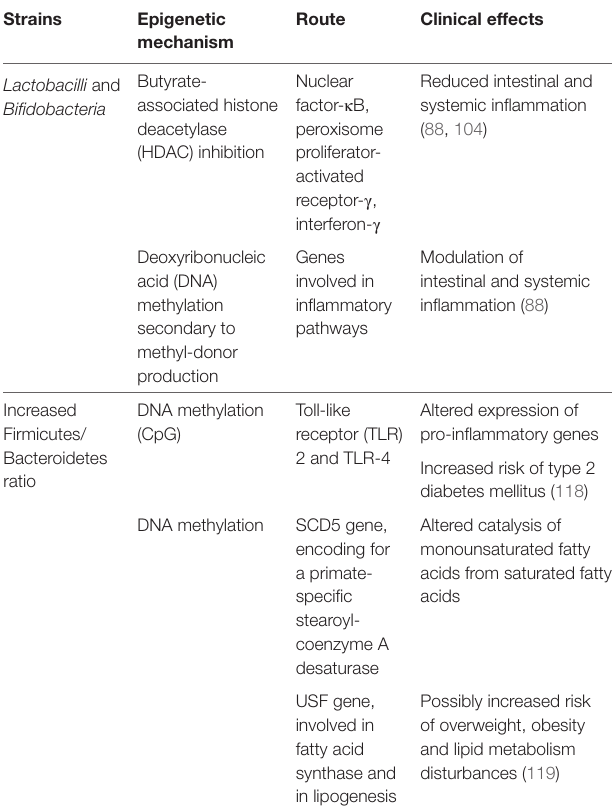
TABLe 3 | Epigenetic modifications associated with specific profiles of gut microbiota.